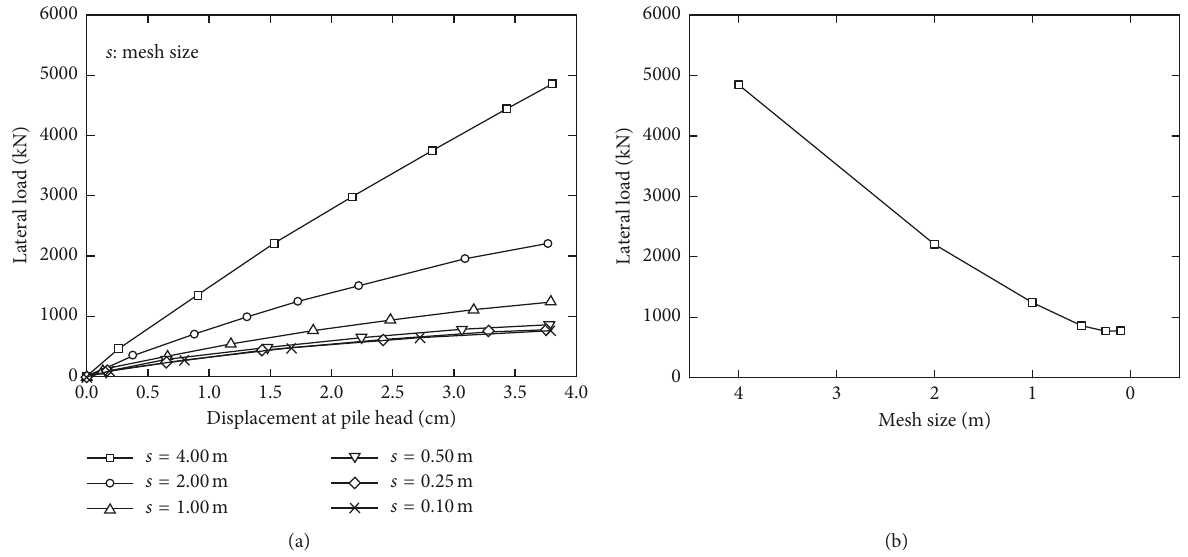
Figure 2: Effect of mesh size on (a) the load-displacement curves at pile head and (b) the required lateral load for a lateral displacement of 38mm.